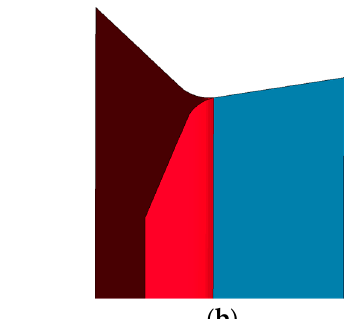
Figure 7. Geometric models of the core for the following versions: ( a ) simple/idealized; ( b ) showing the mapped shape of the rounded walls.